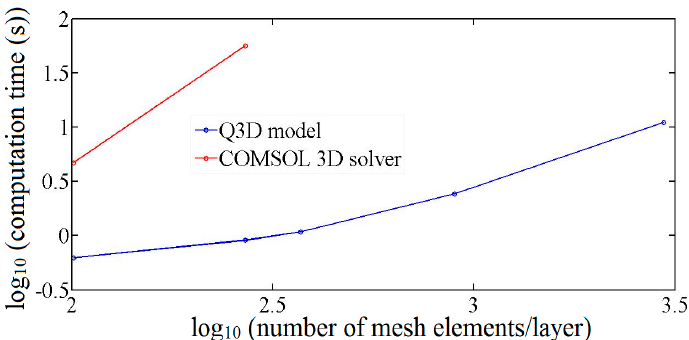
Figure 8. Computation time as a function of the number of mesh elements for the two simulation techniques: Q3D model and COMSOL 3D Incompressible Navier-Stokes module.